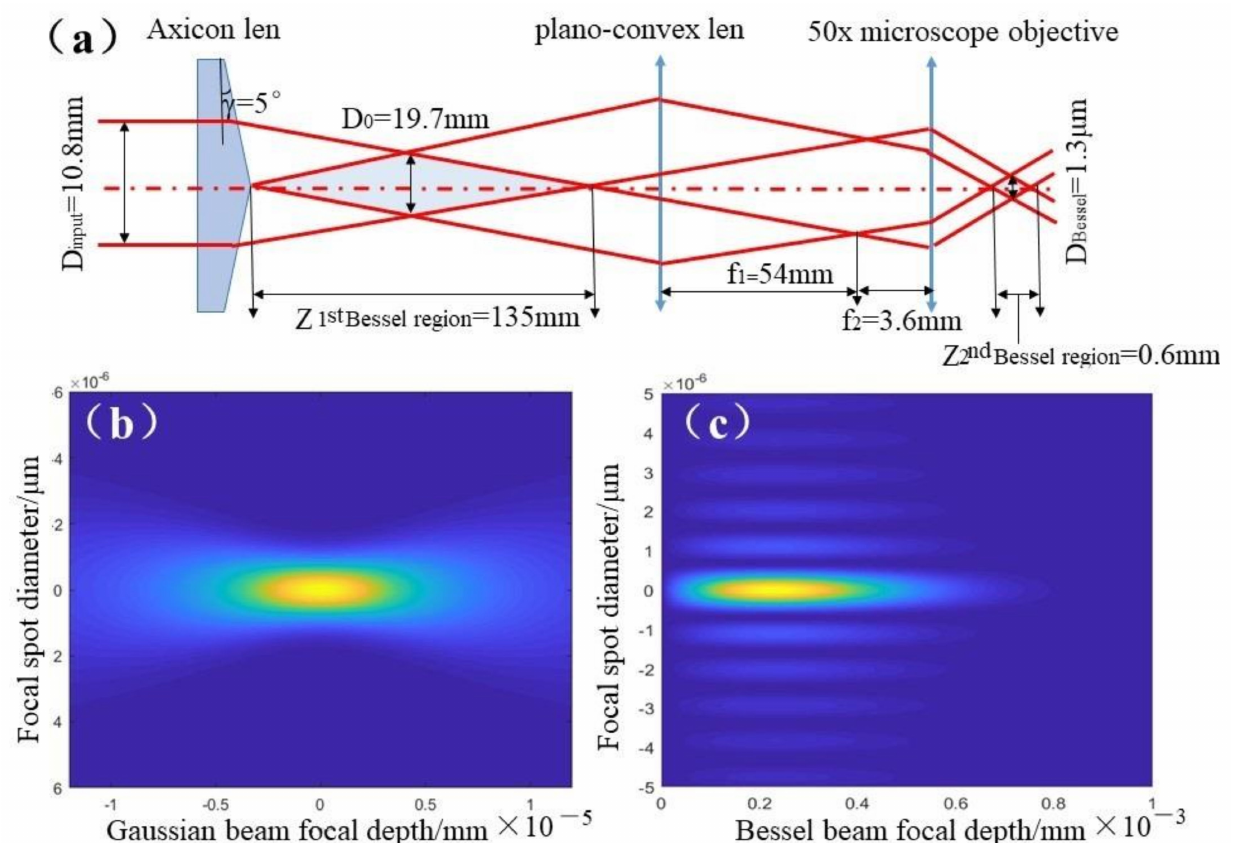
Figure 1. Optical system design and intensity distribution of Bessel laser beam. ( a ) The optical system design of Bessel Beam; ( b ) Laser intensity distribution of Gaussian Beam; ( c ) Laser intensity distribution of Bessel